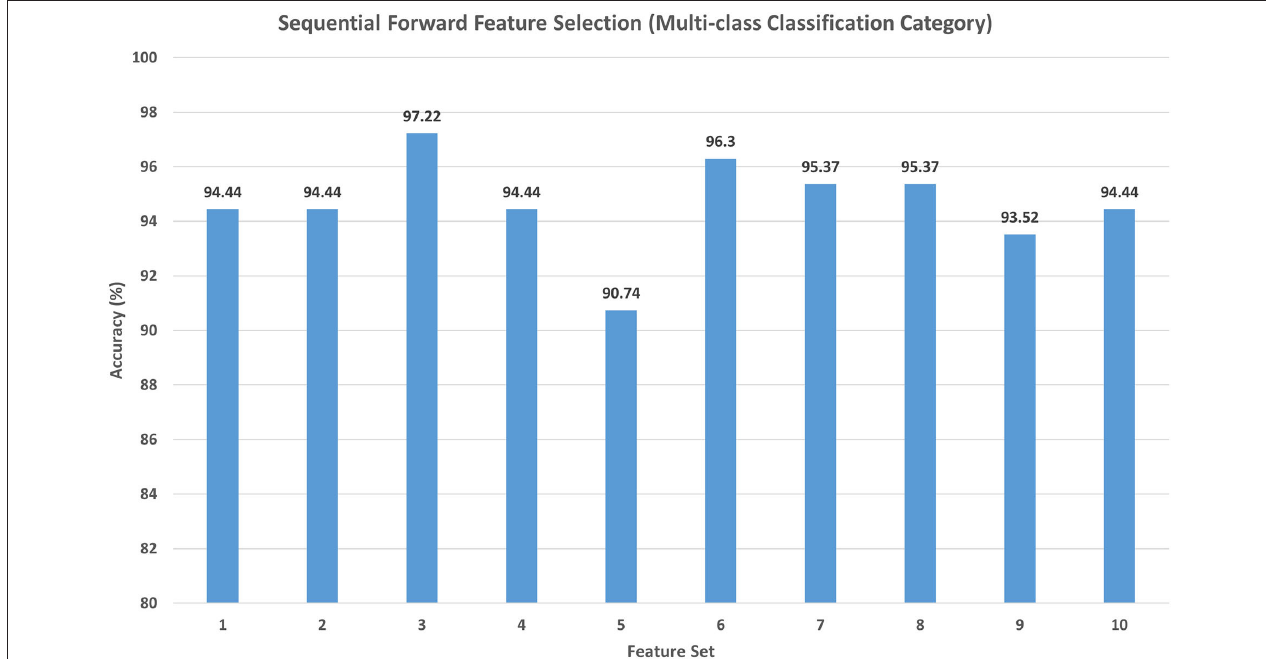
FIGURE 4 | The classification accuracy (%) attained for the different feature sets generated using forward strategy. Feature set 1: DenseNet-201 (1,010 Features); Feature set 2: DenseNet-201 Inception V3(2,034 Features); Feature set 3: DenseNet-201 + Squeeze (1,674 Features); Feature set 5: DenseNet-201